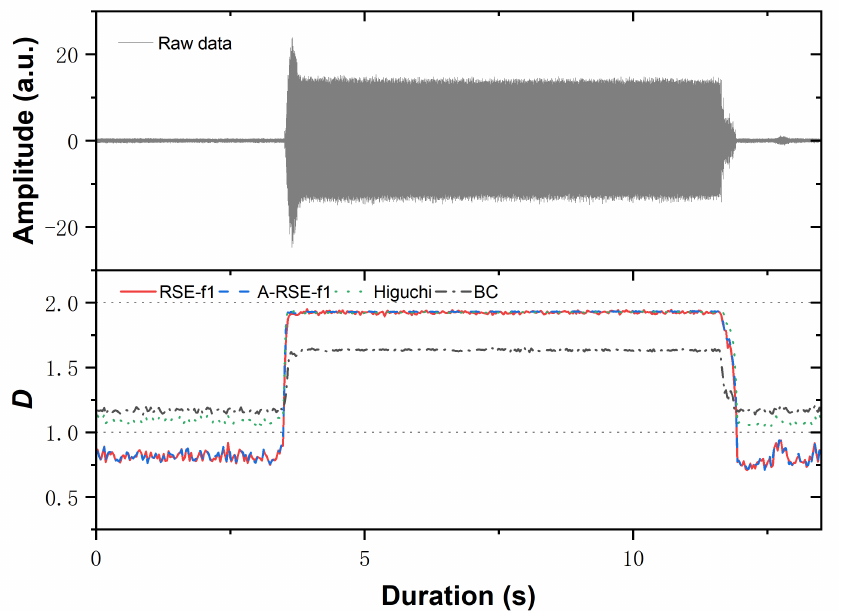
Figure 10. The acceleration signals of chatter status and D values of signal calculated by RSE-f1, A-RSE-f1, Higuchi, and BC